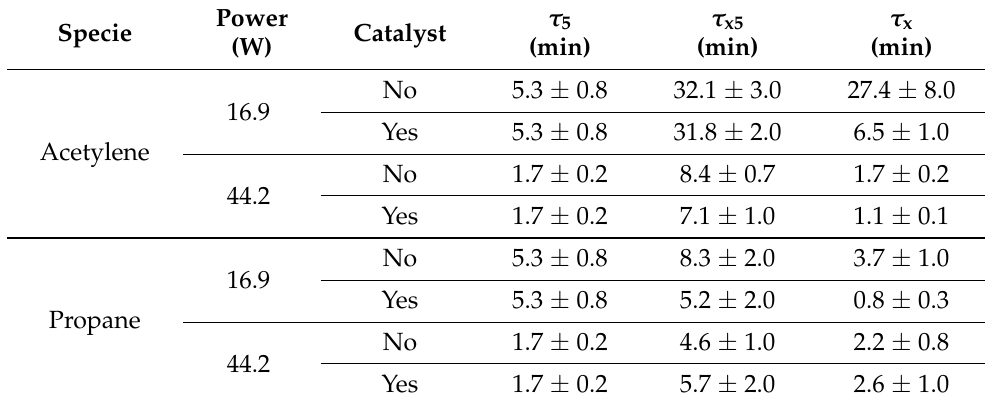
Figure 7. Normalized concentrations of intermediate products, acetylene, and propane, according to treatment time T (min), at 1200ppm initial pentane concentration. ( a , c ) Acetylene at P = 16.9W and P = 44.2W, respectively. ( b , d ) Propane at P = 16.9W and P = 44.2W, respectively. The experimental uncertainties for the product concentrations were obtained by propagating the error due to the initial √ concentration of pentane yielding values equal to 2 10%. The continuous lines are the results of the least-square fits obtained with Equation (4), while the dashed lines are just visual guides. The errors for τ 5 are from Table1 (see also Figure5). The errors associated with τ x and τ x5 are those from the least-square fits and are reported in Table2. Table 2. Acetylene and propane characteristic times for different plasma treatments. The initial pentane concentration for this table corresponds to 1200ppm. The errors for τ x and τ x5 were obtained as discussed in